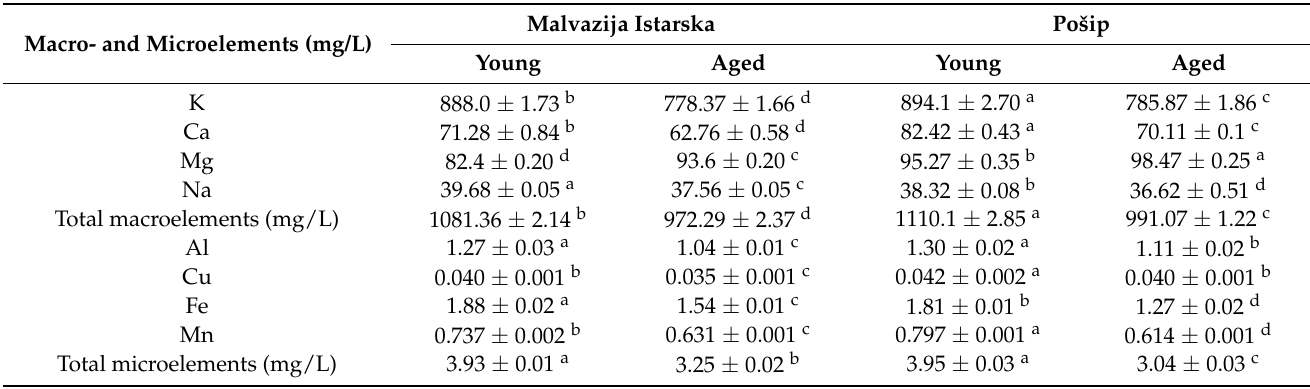
Table 5. Concentration (mg/L) of macro- and microelements of young and aged Malvazija istarska and Pošip wines.